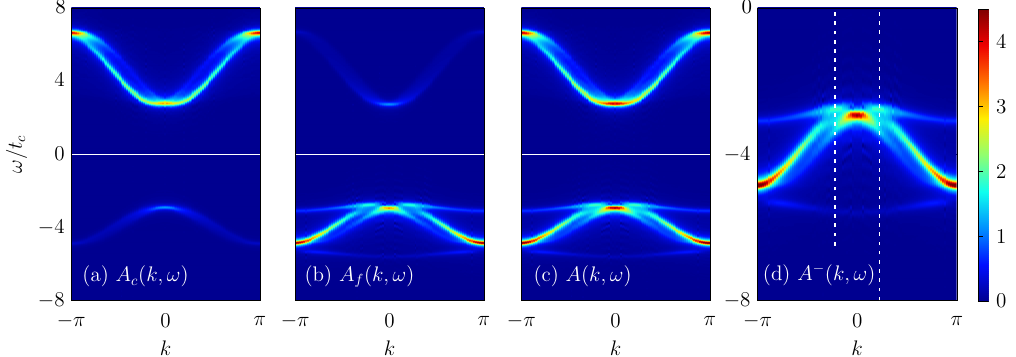
Figure 3: Single-particle spectral functions in the 1D half-filled EFKM with / t = − 0.5, D / t = 0.53, and U / t t f c c